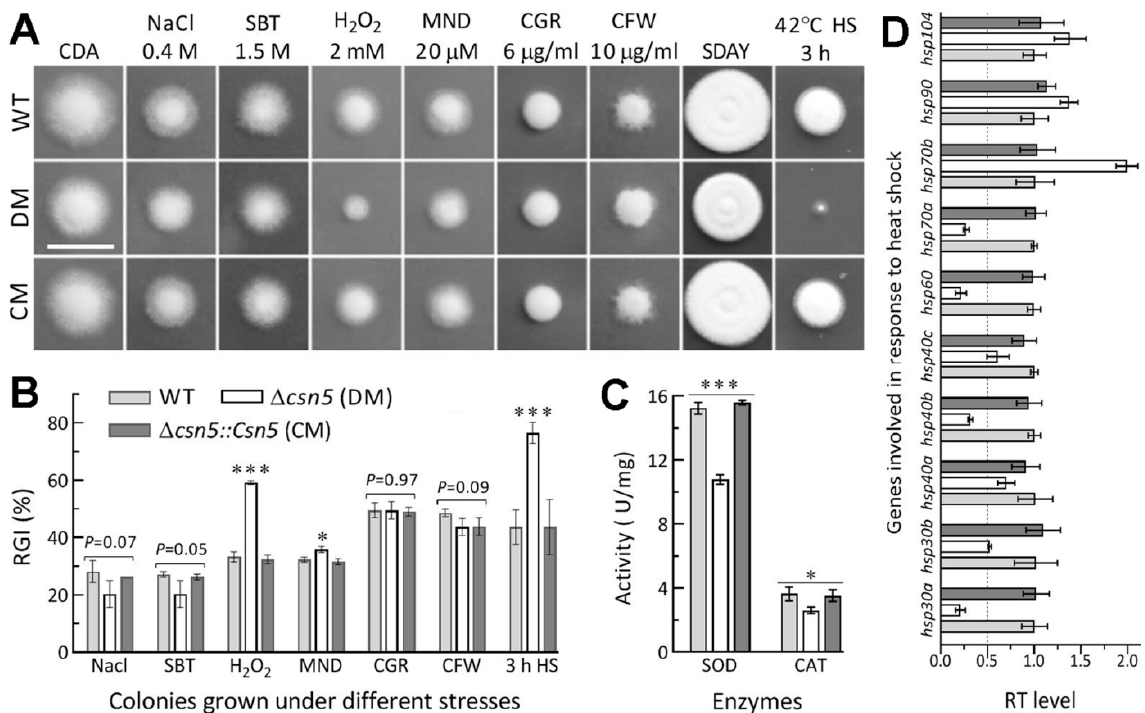
Figure 3. Impacts of csn5 disruption on radial growth under normal and stressful conditions. ( A ) Images (scale bar: 2 cm) for 8-day-old colonies grown at 25°C on rich SDAY alone (control) or exposed to a 3-h heat shock at 42°C after 2-day growth as well as minimal CDA alone (control) or supplemented with the indicated concentrations of chemical stressors (SBT, sorbitol; MND, menadione; CGR, Congo red; CFW, calcofluor white). ( B ) Relative growth inhibition (RGI) percentages of fungal colonies under the stressors. All colonies were initiated by spotting 1 μ L aliquots of a 10 6 conidia/mL suspension. ( C ) Total activities of superoxide dismutases (SOD) and catalases (CAT) quantified from the protein extracts of 3-day-old SDAY cultures. ( D ) Relative transcript (RT) levels of heat-responsive genes in the 3-day-old SDAY cultures of csn5 mutants with respect to the WT standard. The dashed line indicates a significant level of one-fold (50%) downregulation. * p < 0.05 or *** p < 0.001 in Tukey’s HSD tests. Error bars: SDs of the means from three independent replicates.